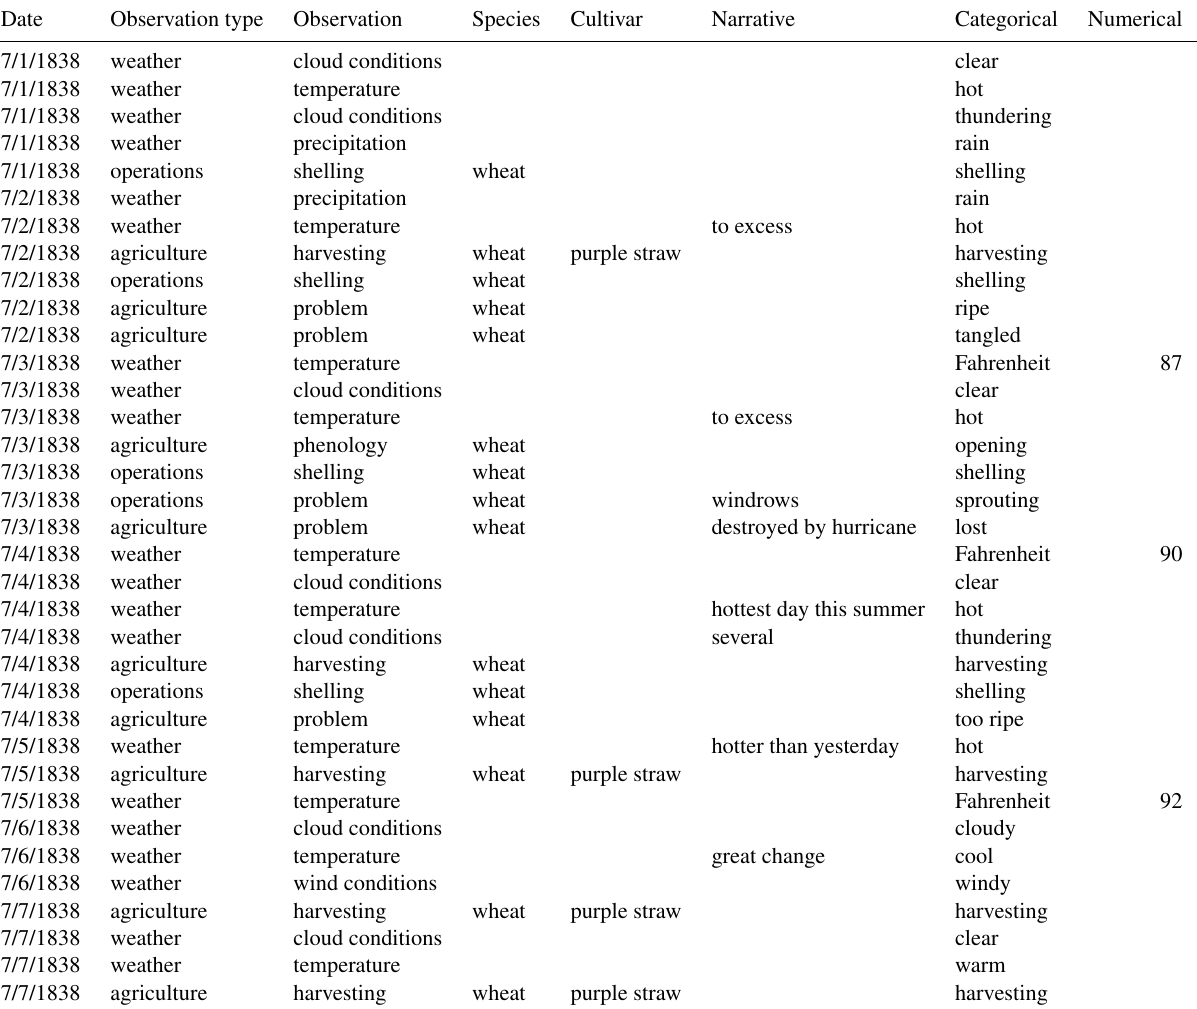
Table 5. Example of the database extracted from the Shirley Plantation document covering the period 1–7 July 1838. Dates are indicated in mm/dd/yyyy